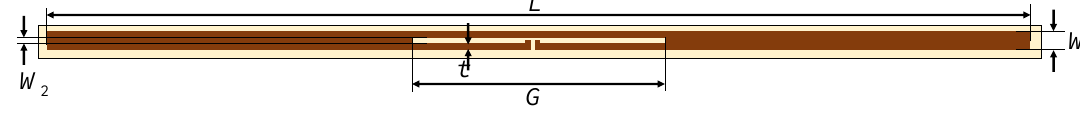
Figure 1. Layout of the proposed Radio Frequency Identification (RFID) antenna. Dimensions in mm: L = 109.0, W = 3.5, W 2 = 2.0, G = 28.0, t =